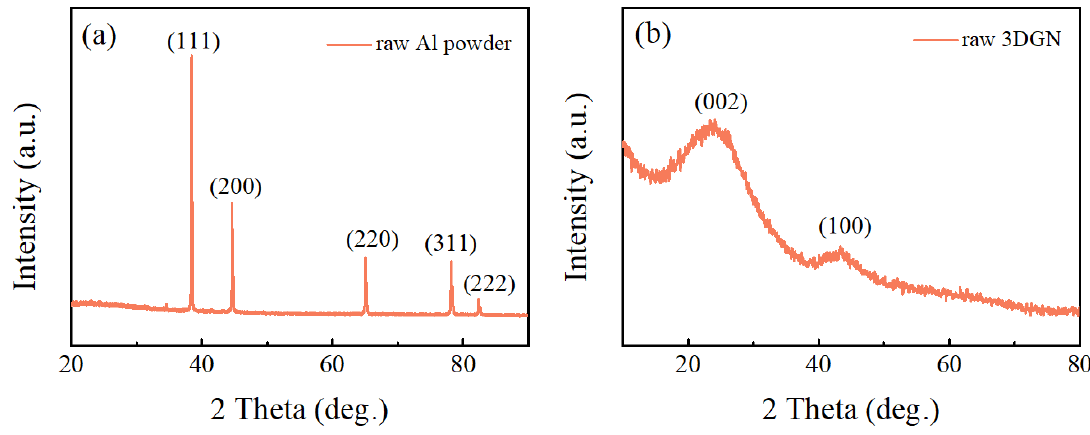
Figure 2. XRD spectra of raw materials ( a ) Al powder and ( b ) 3DGN.